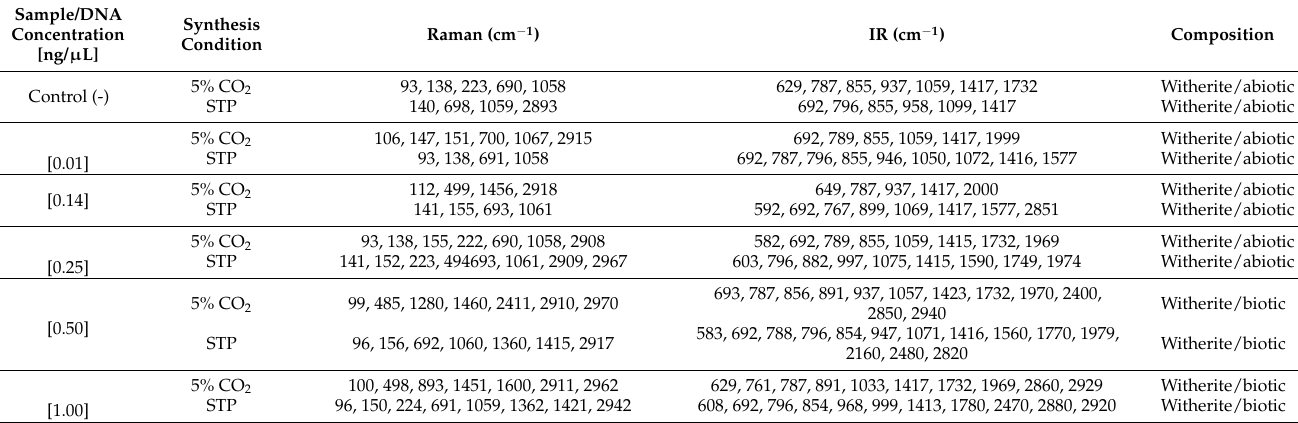
Table 1. Identification through Raman and IR spectroscopy of the polymorphs of the barium silica- carbonate biomorphs.